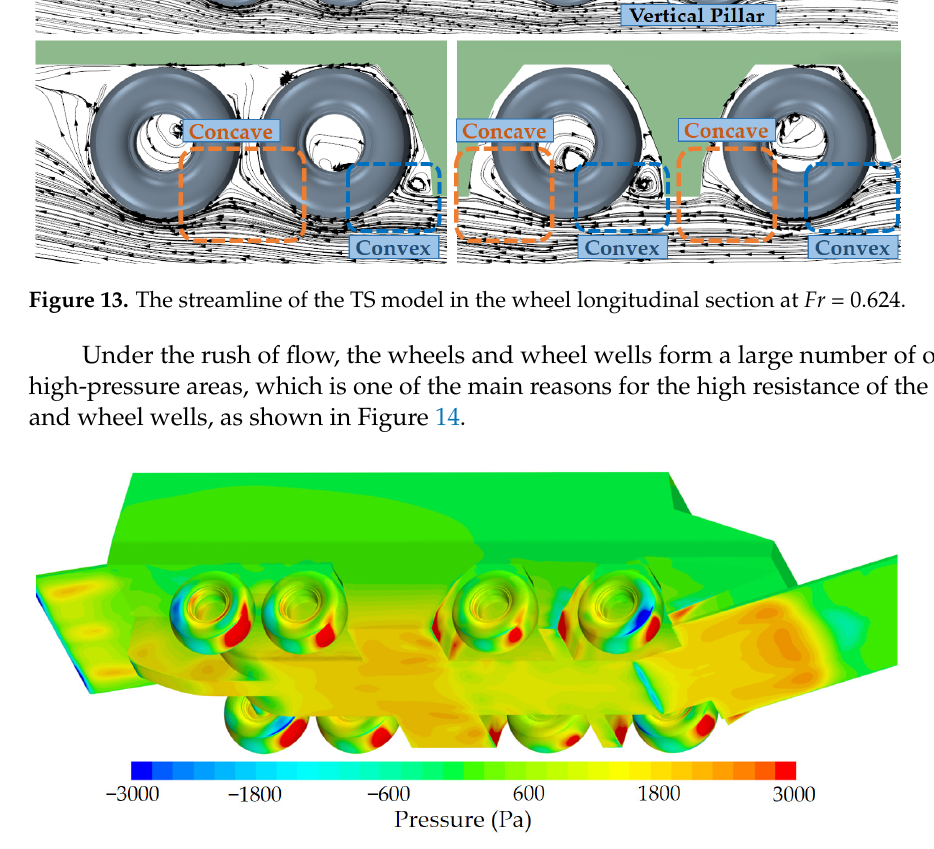
Figure 15. The resistance of the wheels of the TS model at Fr = 0.624. 3.1.2. The Geometry Unchanged Parts The influence of the wheels and wheel wells on the flow field around themselves will also change the forces on the geometry unchanged parts. As shown in Figure 12, under the local effect of the wheels, the resistance of the bow breakwater and the vehicle body